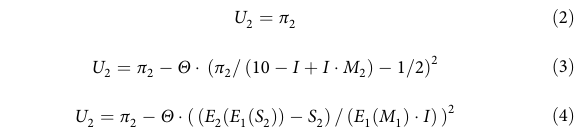
Figure 12. To ensure that our model was not over fi tting the data, and to estimate the stability of decisions within subjects over time, we performed cross-validation on the model predictions. For this step, we divided the 76 trials with nonzero investment for each participant into fi ve equal parts ( fi vefold cross-validation). For each fold, we fi t the model to the remaining 4/5 of the data, and predicted the behavior in the held-out 1/5. We compared the model predictions to the true held- out data across all folds by computing the mean squared prediction error per trial, the Pearson correlation coef fi cient r , and r 2 . We tested prediction quality with a t test on the r values against 0. In this test, we excluded one participant for whom both the model predictions and the actual behavior were always to return 0 tokens, which caused the correlation to be unidenti fi able. Overall, we observed a high degree of model accuracy (mean squared error per trial = 5.37, mean r 2 = 0.86; one-sample t test on r values: t (55) = 66.1, p < 0.001). We ran parameter recovery analyses to ensure that our model was